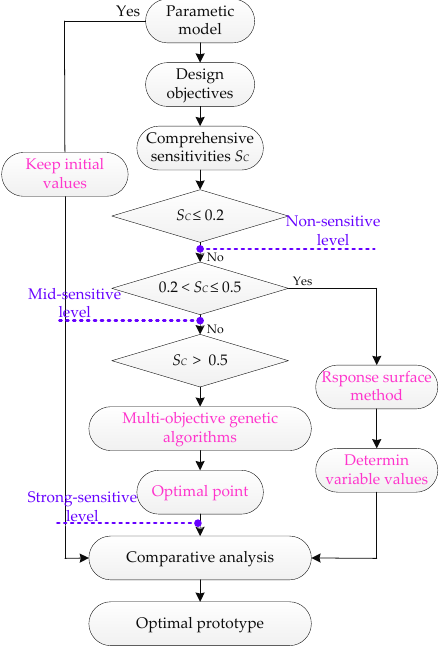
Figure 6. Flowchart of multi-level design optimization.